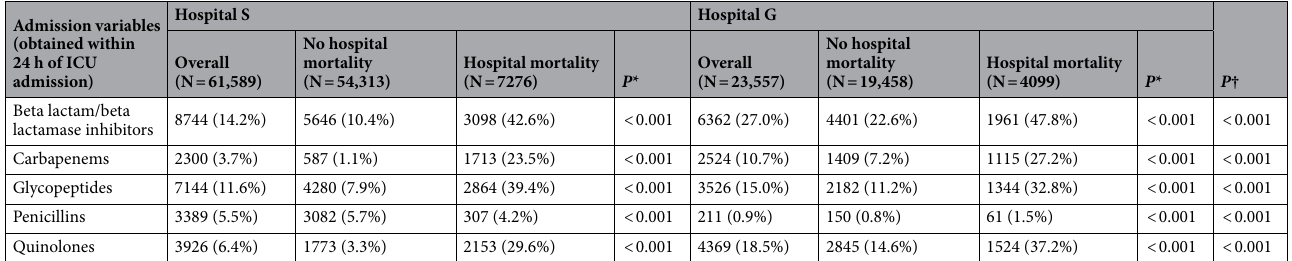
Table 1. Baseline characteristics and physiological variables obtained within 24 h of ICU admission. Characteristics are summarized as the median [IQR], or n (%). ICU intensive care unit, APACHE Assessment and Chronic Health Evaluation, SAPS Simplified Acute Physiology Score, MPM Mortality Probability Model, SOFA Sequential Oran Failure Assessment. * P value for difference between cases with and without in-hospital mortality. † P value for difference between hospital S and hospital